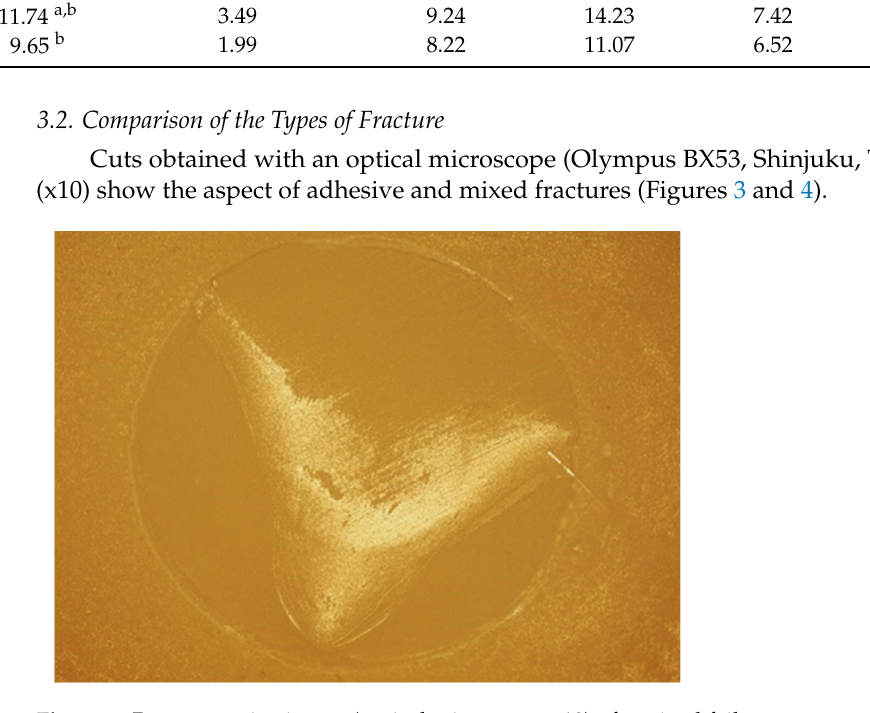
Figure 3. Representative image (optical microscope x10) of a mixed